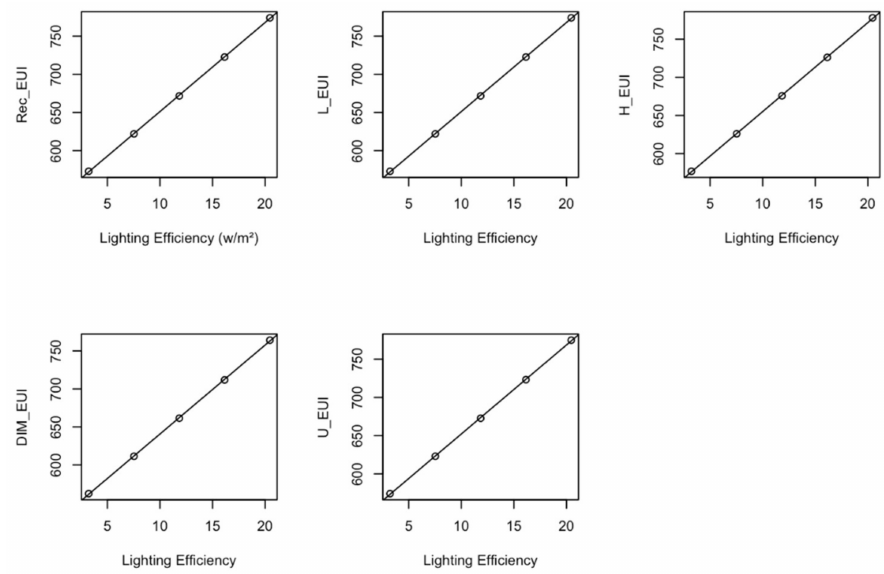
Figure 15. Lighting efficiency fitted line diagrams.